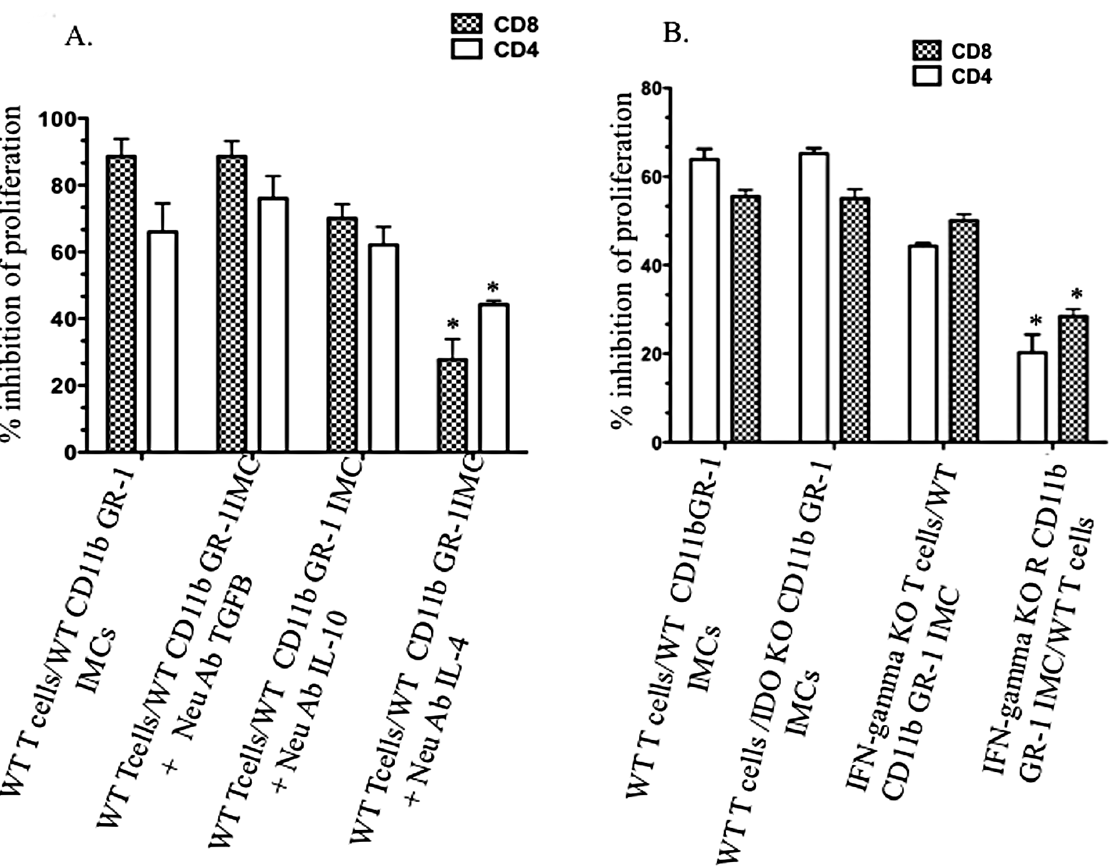
Figure 5. Partially abrogation of IMC-suppression by IL-4 neutralizing antibody and IFN- c KO IMCs. A) Inhibition of Dynabead-induced proliferation of T-cells in co-culture with CD11b + GR-1 + IMCs was measured in the presence of neutralizing antibodies to TGF b (p . 0.05) , IL-4 ( p =0.0103), and IL-10 ( p . 0.05 ). B) Inhibition of proliferation of T-cells in co-culture with CD11b + GR-1 + IMCs isolated from wild-type mice (controls) or knock out mice for IDO (p . 0.05) , and IFN- c receptor ( p =0.0358). Additional combination used wild-type IMCs co cultured with IFN- c KO T-cells. Data represent the mean and SD of three experiments.